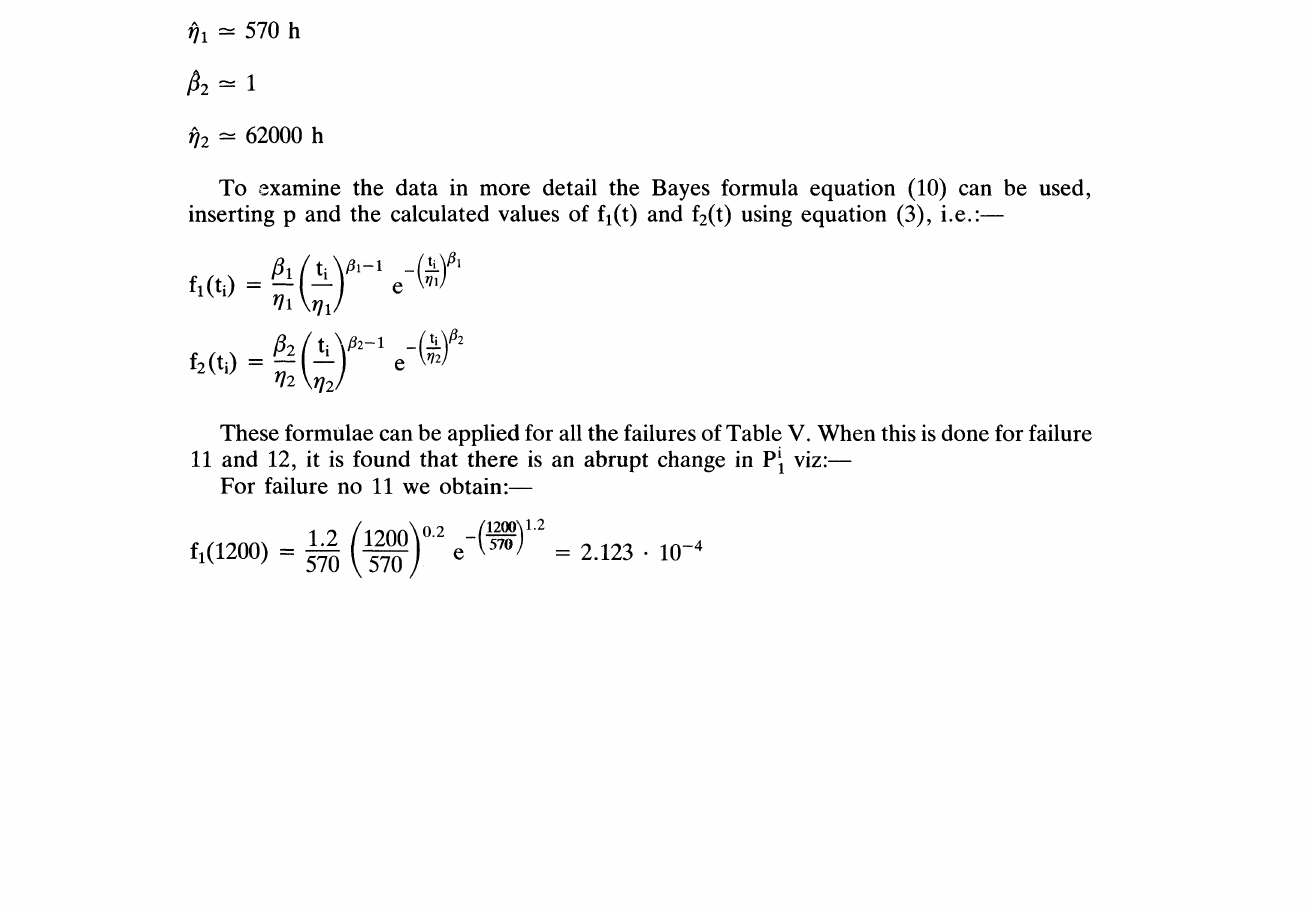
FIGURE 10 Weibull-plot for components with a bimodal lifetime distribution. (Sample size n